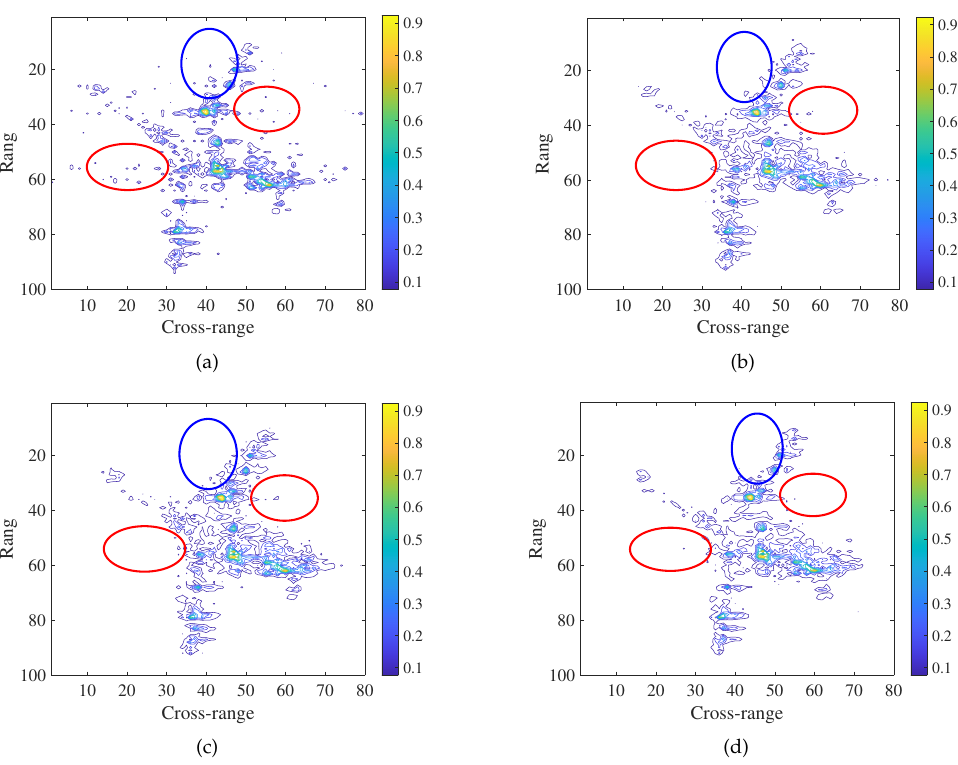
Figure 8. The imaging results of plane data obtained by ( a ) GKF imaging method, ( b ) ONDL imaging method, ( c ) OFDL imaging method and ( d ) the GDL imaging method, using 50% measurements.